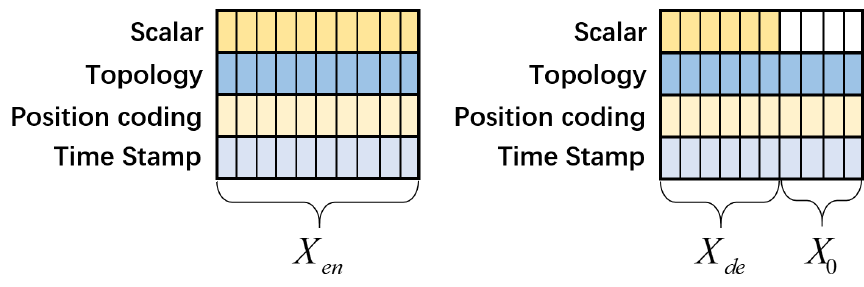
Figure 6. The inputs of the encoder–decoder